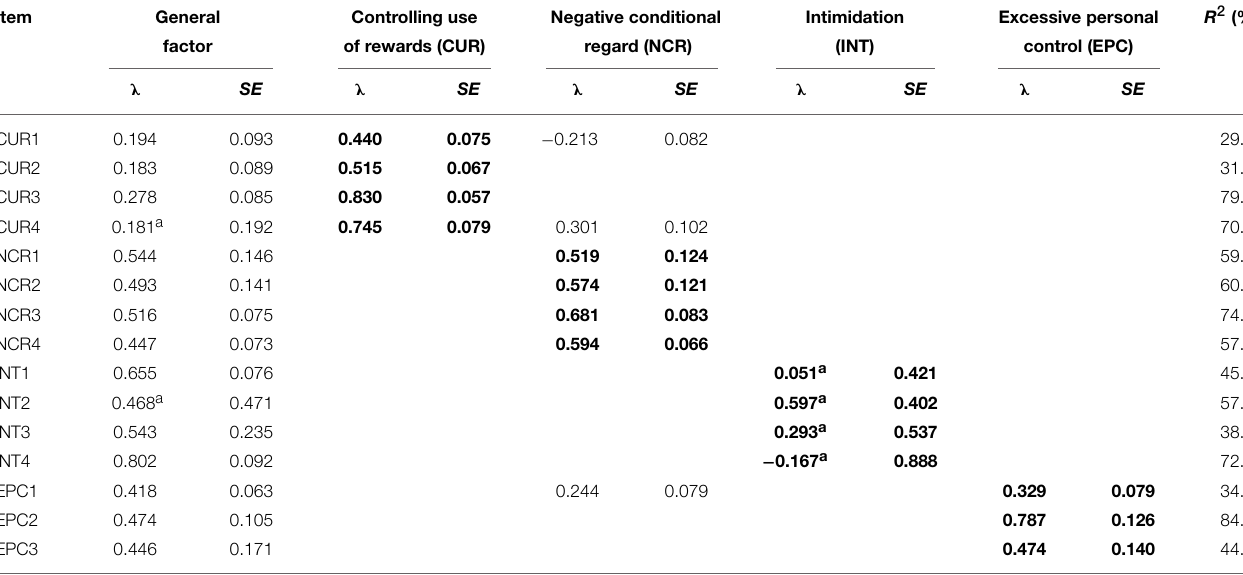
TABLE 7 | Standardized Loading Pattern for the Bifactor ESEM of the CCBS ( N = 233 ). Item